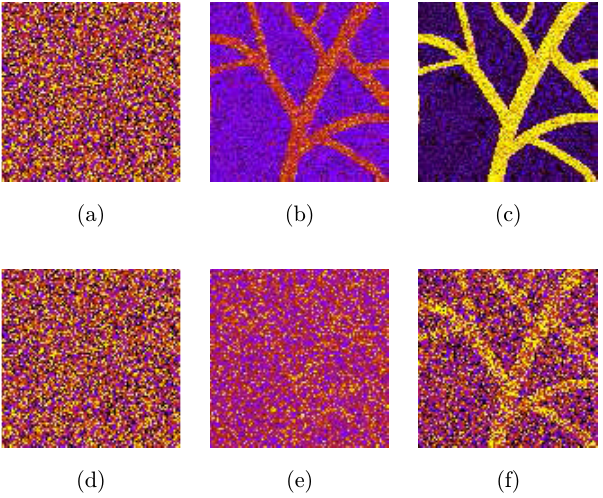
Fig. 2. Localization of rhythmic activity in a speci¯c fre- quency domain. Surrogate data, 100 (cid:2) 100 pixels. Oscillations with the period of 30 s are attributed to the tree-like object. Top and bottom rows are obtained at noise amplitude of 50% and 200% of signal amplitude, respectively. (a) and (d) shows time averaged LSI data; (b) and (e) Fourier power spectrum at frequency f ¼ 0 : 30468; (c) and (f) WT spectral power at fre- quency f ¼ 0 : 30. N A ¼ 1.